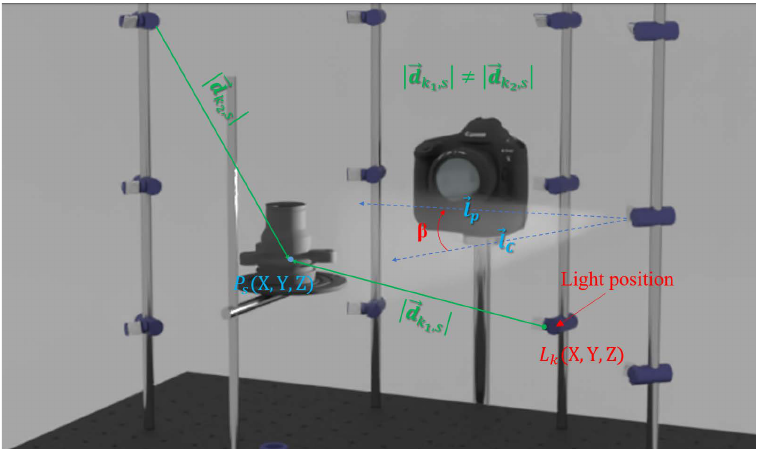
Figure 4. Radial and angular intensity